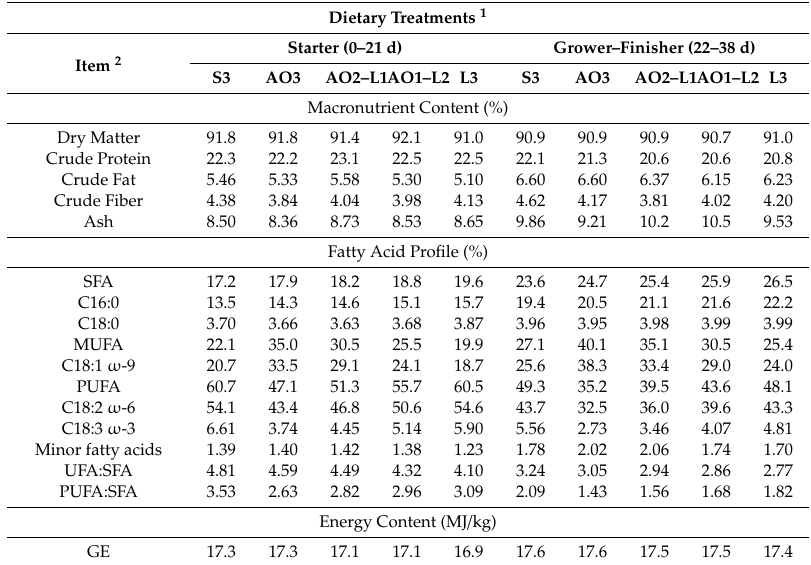
Table 4. Analyzed gross energy, macronutrient content, and fatty acid composition of starter and grower–finisher broiler chicken diets (Experiment 2).